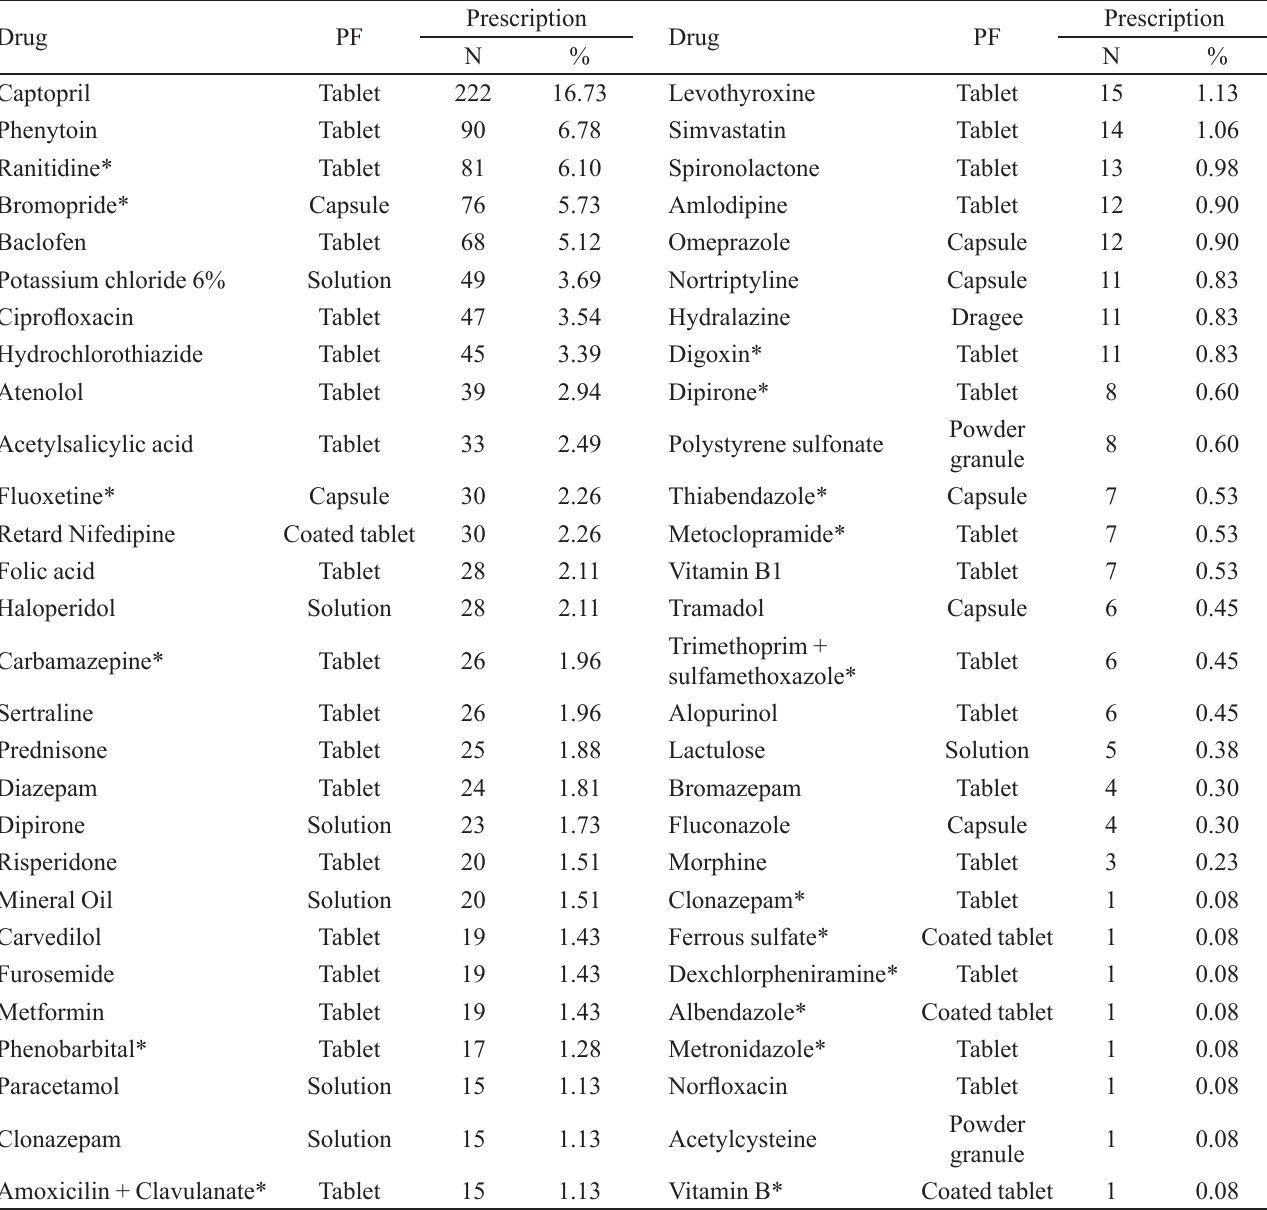
TABLE I - Frequency of medications prescribed for administration through enteral feeding tubes among the 26 patients assessed between January and June, 2007 at the Hospital dos Servidores do Estado (HSE) in Rio de Janeiro